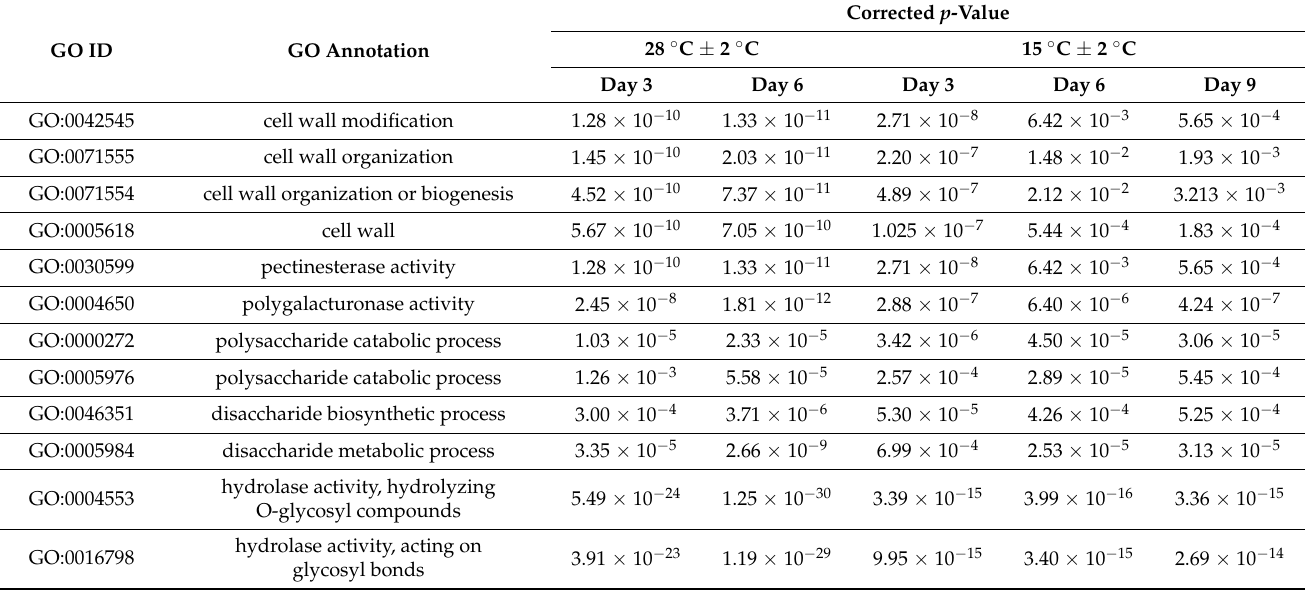
Table 2. Enriched GO terms related to the cell wall, pectin, carbohydrates (polysaccharide and disaccharides), and